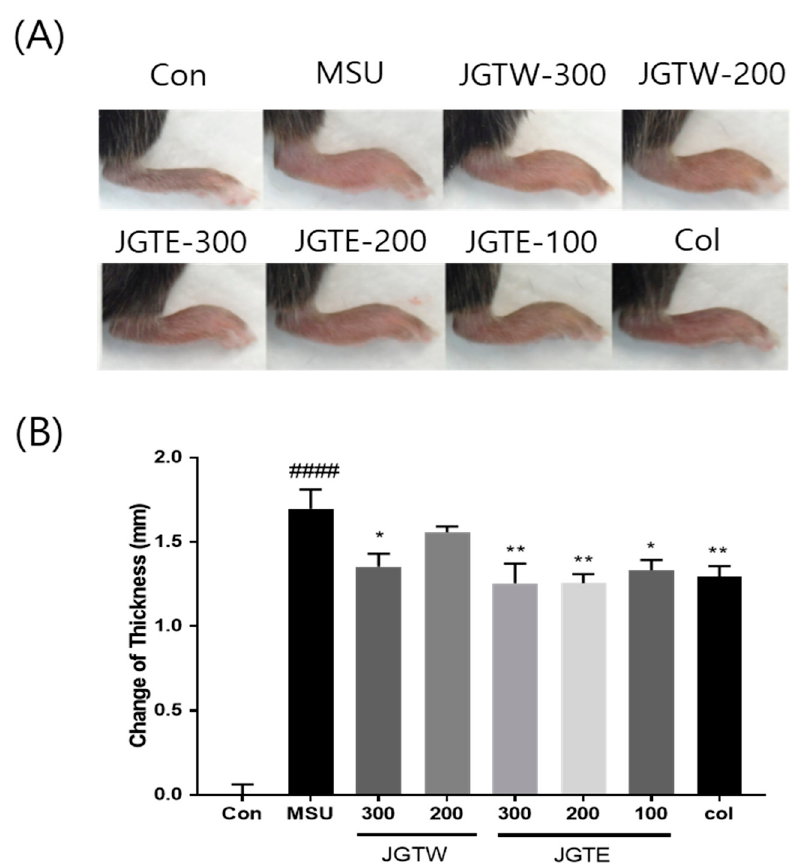
Figure 3. Effect of JGTW and JGTE on paw oedema in mice with monosodium urate (MSU) crystal-induced gouty arthritis. Con, control mice; MSU, MSU crystal-injected mice; JGTW, MSU-injected mice treated with JGTW; JGTE, MSU-injected mice treated with JGTE; Col, MSU-injected mice treated with 1 mg/kg of colchicine. ( A ) Representative images of the right leg from mice in each group are shown. ( B ) Measurement of the thickness of each mouse paw recorded at the end of the experimental period. Data are presented as the mean ± SEM ( n = 5). #### p < 0.0001 vs. Control group and * p < 0.05, ** p < 0.01 vs. MSU group.